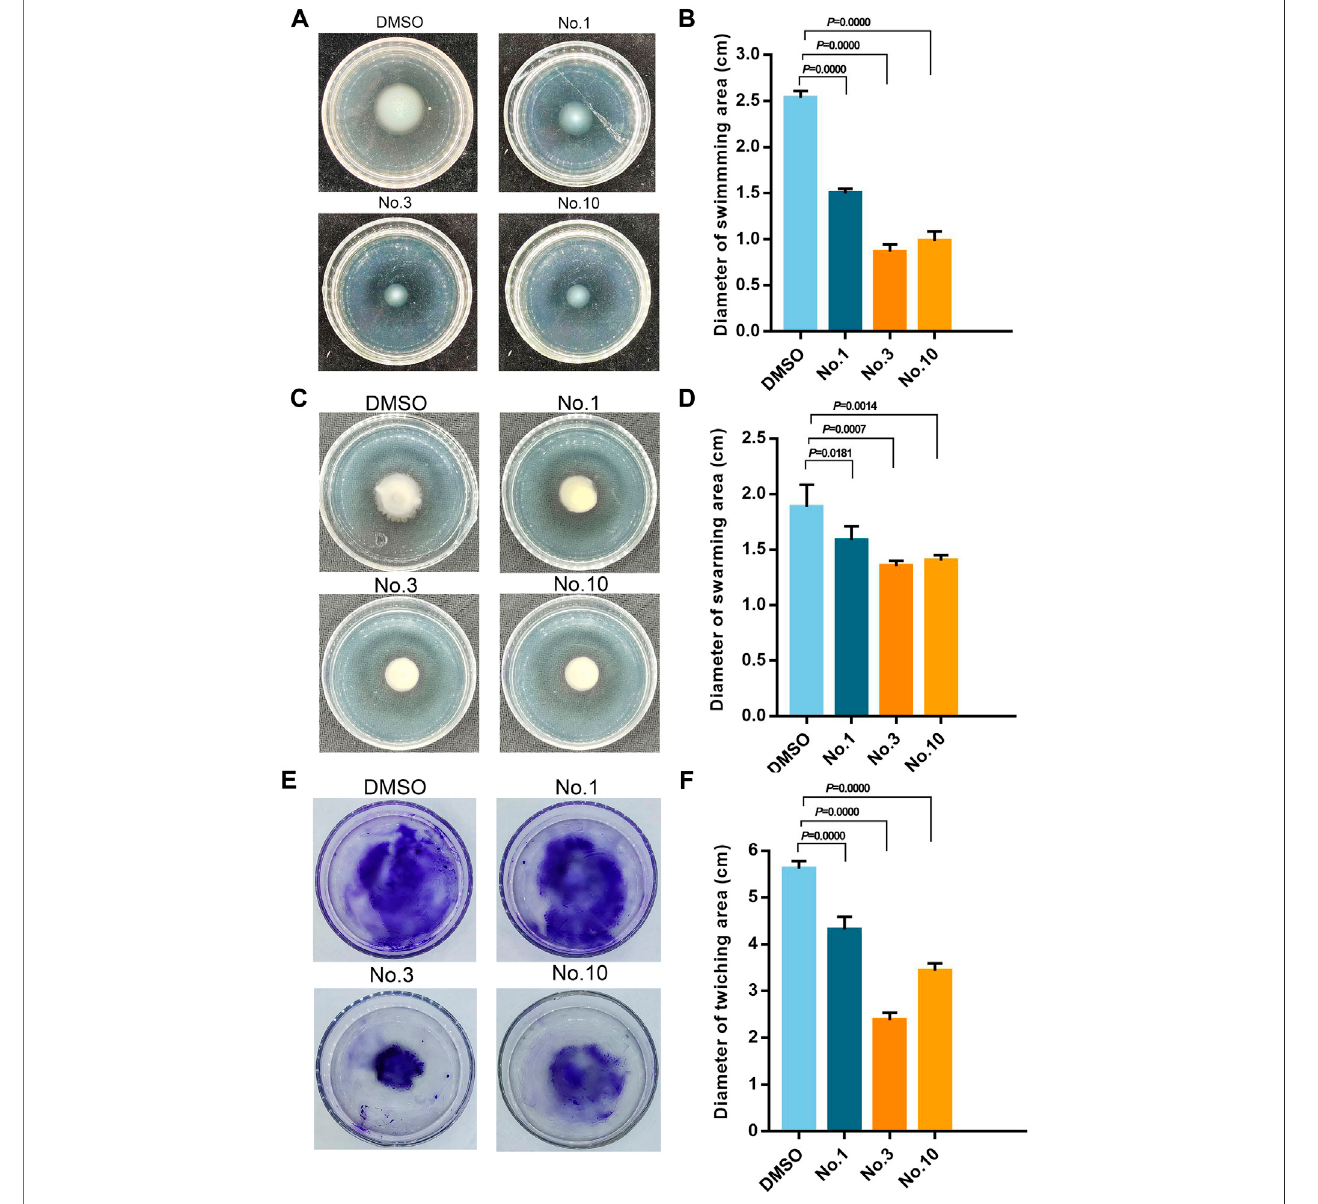
FIGURE5| Inhibitoryeffectofcompoundno.3andcompoundno.10on P.aeruginosa motility. (A) and (B) representswimmingmotilityof P.aeruginosa PAO1, (C) and (D) represent swarming motility of P. aeruginosa PAO1, (E) and (F) represent twitching motility of P. aeruginosa PAO1. DMSO and compound no.1 represent negative and positive control,